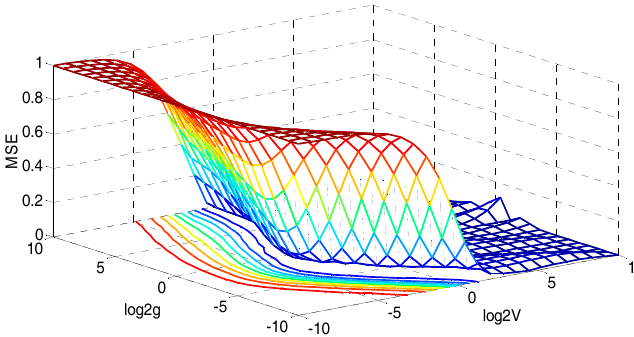
Figure 9. The relationship between MSE and parameters V , g .